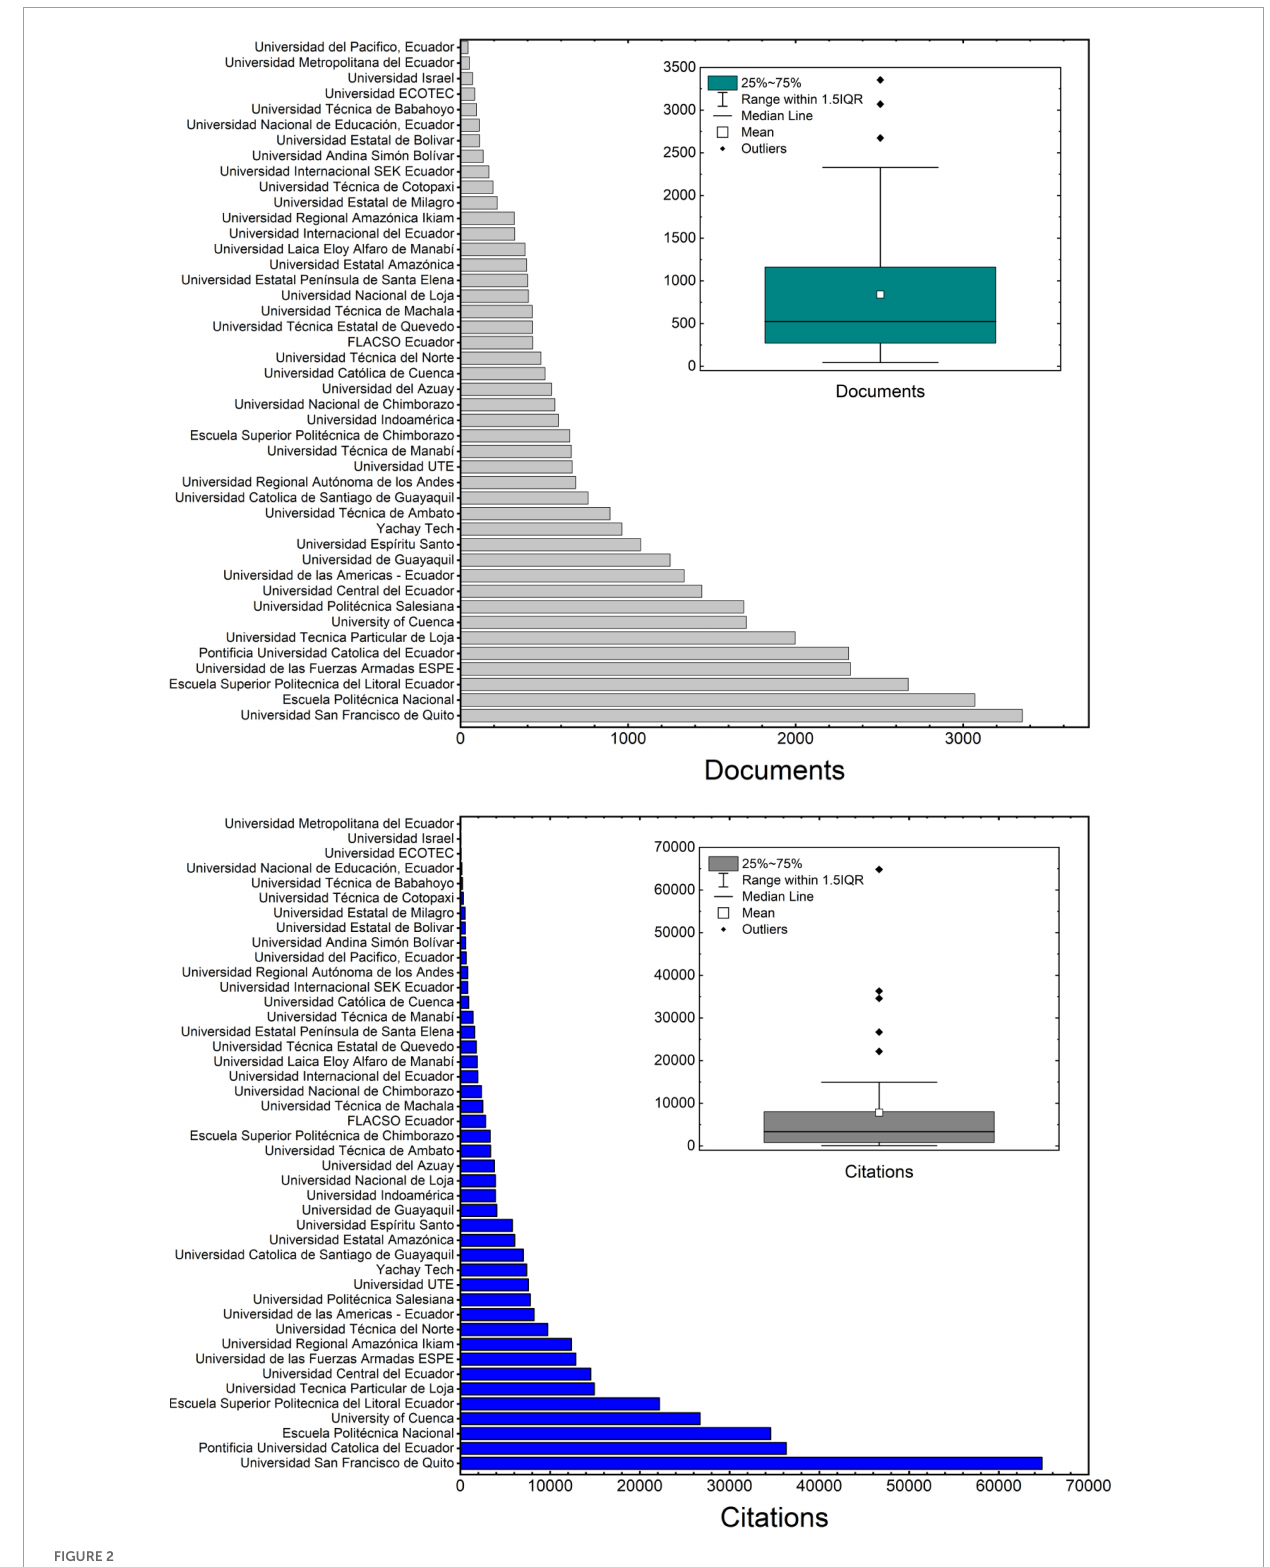
FIGURE2 The total number of documents (Left) and citations (Right) per university and their statistical distribution as of 01/28/2022.